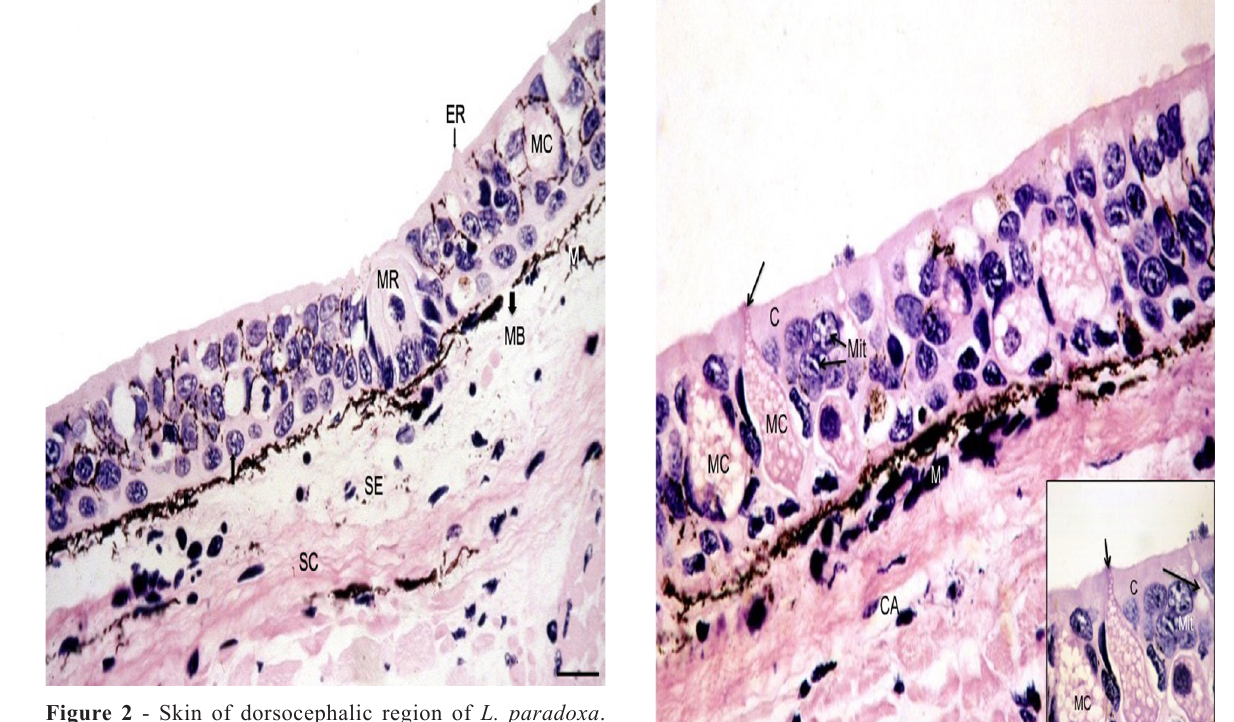
Figure 2 - Skin of dorsocephalic region of L. paradoxa . epidermal basal cells (arrow) with an underlying basement membrane (BM arrow) and mucus-secreting (MC) cells. A mechanoreceptor (Mr) is visible at the external end of the electroreceptor (er). The stratum spongiosum and compactum (Se-SC) of the dermis with melanophores (M) are also visible. H-E. Bar: 100 μm.